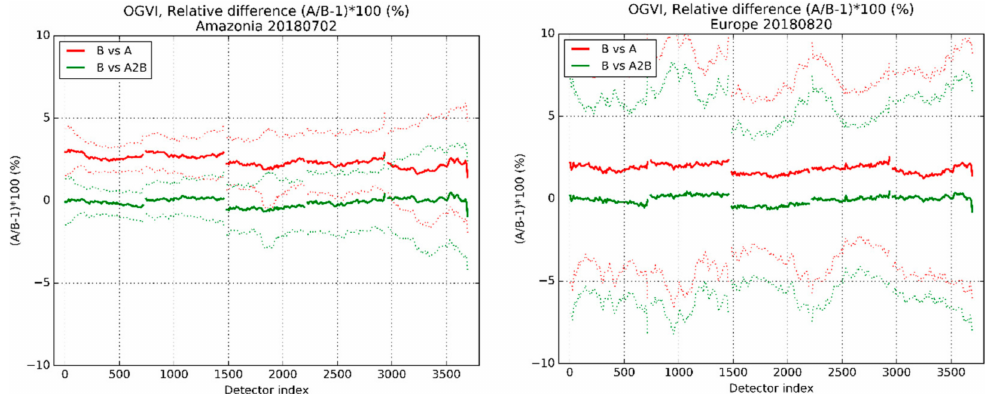
Figure 6. OGVI relative di ff erences of OLCI-A baseline (“A”, red) and harmonised (“A2B”, green) with OLCI-B for Amazonia ( left ) and Europe ( right ). Median and dispersion per OLCI detector. The OGVI values are better aligned after harmonisation with very small relative di ff erences (green lines). The results over Europe and Amazonia are similar, except for the higher dispersion for the Europe scene due to the larger inhomogeneity of the sampled vegetation